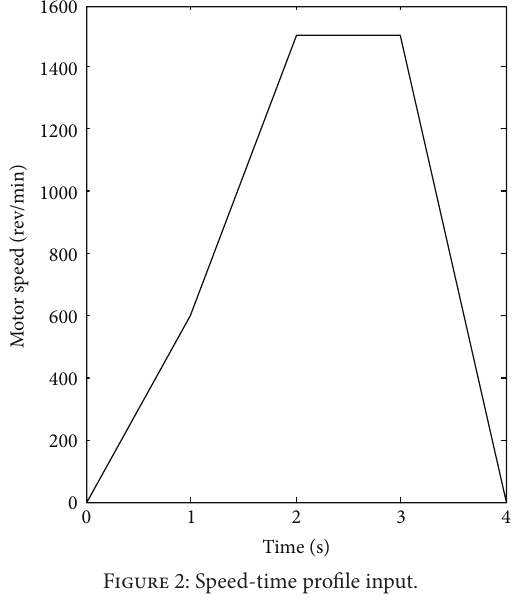
Figure 2: Speed-time profile input.